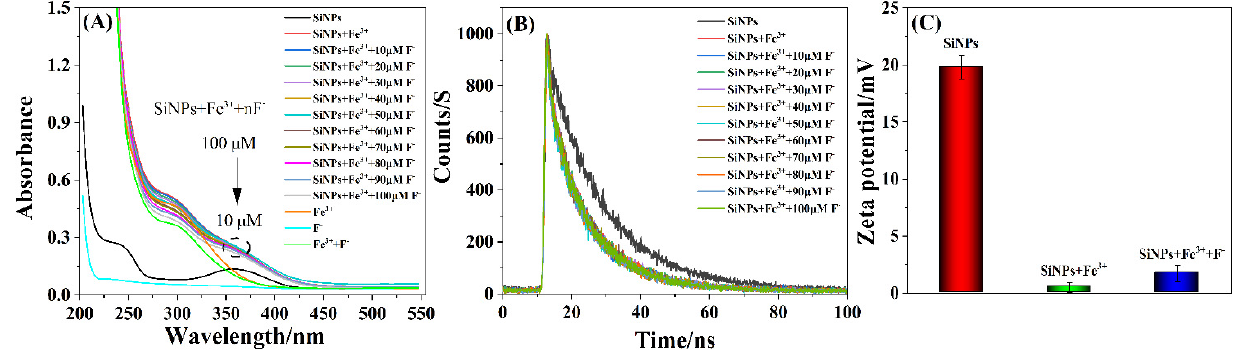
Figure 8. ( A ) UV–vis absorption spectra, ( B ) the fluorescence decay curves, and ( C ) the zeta poten ‐ tials of the SiNPs, SiNPs+Fe 3+ , and SiNPs+Fe 3+ +F − systems. of the SiNPs, SiNPs+Fe 3+ , and SiNPs+Fe 3+ +F −